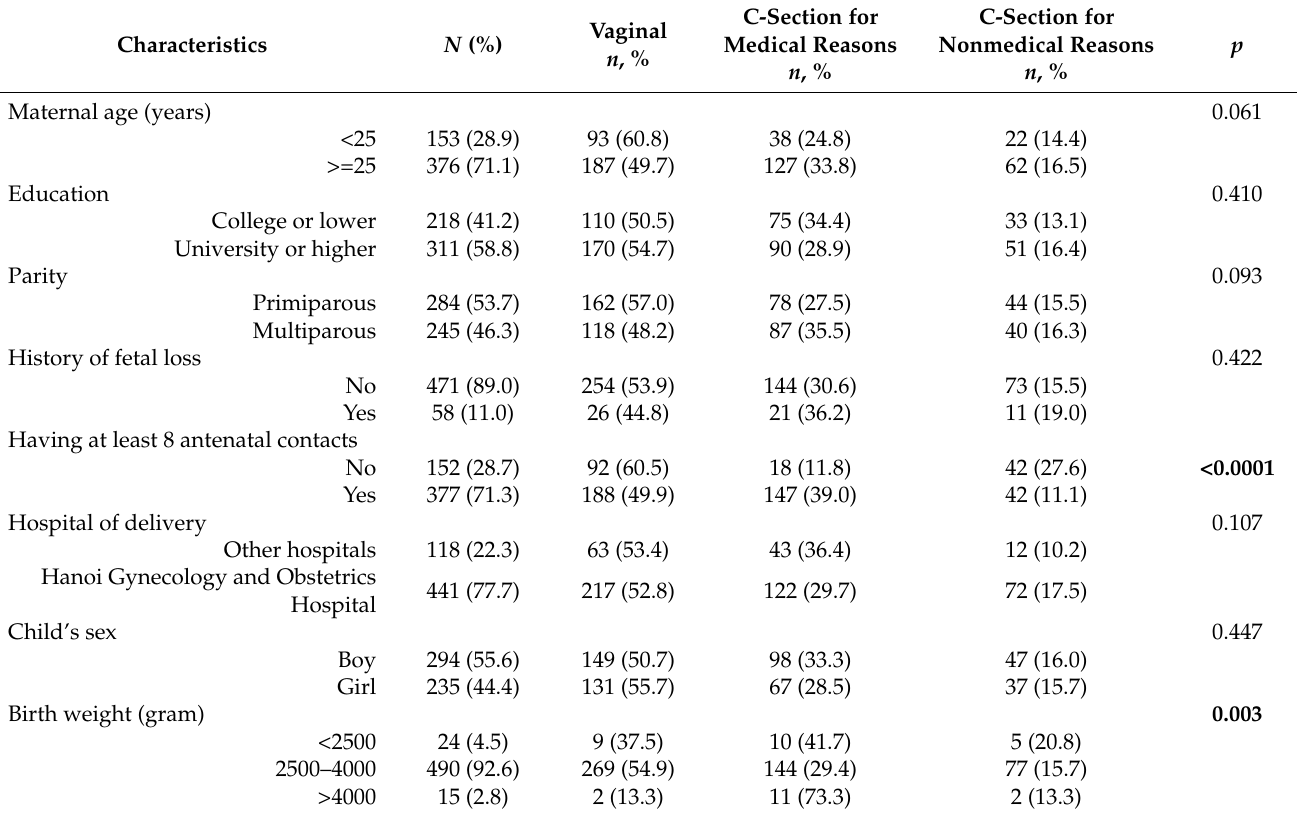
Table 2. Characteristics of mothers and infants by mode of delivery in Hanoi 2021 ( N =